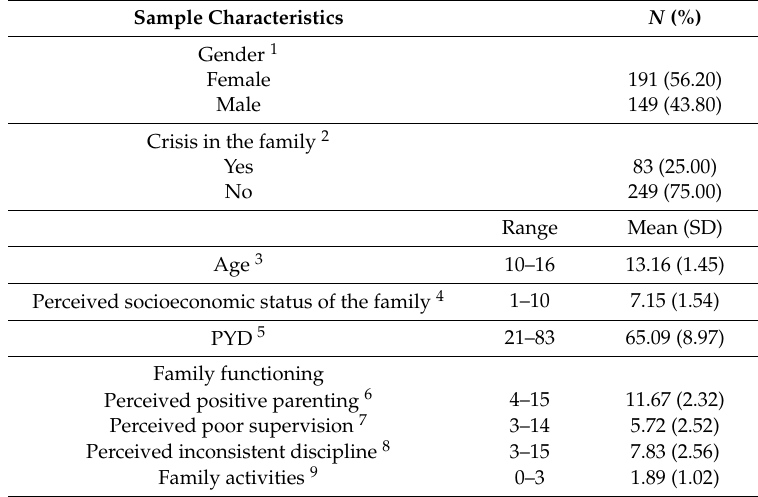
Table 1. Background characteristics of the sample (341 Slovak adolescents aged 10–16, collected in